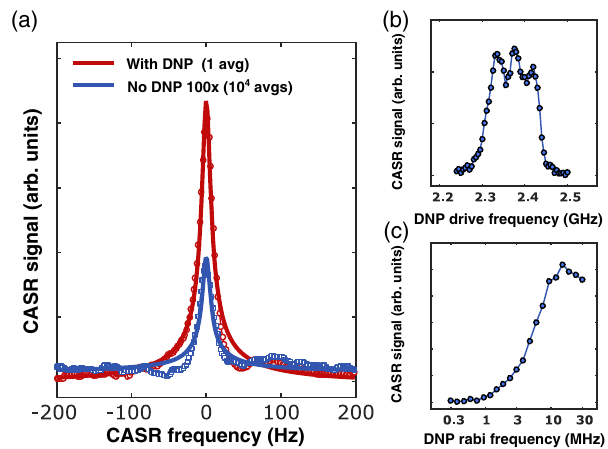
FIG. 2. Hyperpolarization-enhanced NV NMR of water. (a) Comparison of NV NMR spectra obtained from pure water with DNP (red circles, 1 spectrum averaged) and without DNP (blue circles, 10 4 spectra averaged) using a coherently averaged synchronized readout (CASR) pulse sequence. Line shape fits (solid lines) indicate a DNP signal enhancement of 230, with a proton number sensitivity of 10 pmol = Hz 1 = 2 for a signal-to-noise ratio (SNR) of 3. (b) Magnitude of CASR-detected signal from a sample of pure water as a function of DNP drive frequency. The triplet structure arises from hyperfine coupling between the electron and 14 N nuclear spins in the TEMPOL radical. (c) Mag- nitude of CASR-detected signal from a sample of pure water as a function of DNP drive power, expressed in units of the electron Rabi frequency (see methods for details). The maximum DNP signal enhancement is reached at a drive Rabi frequency of approximately 10